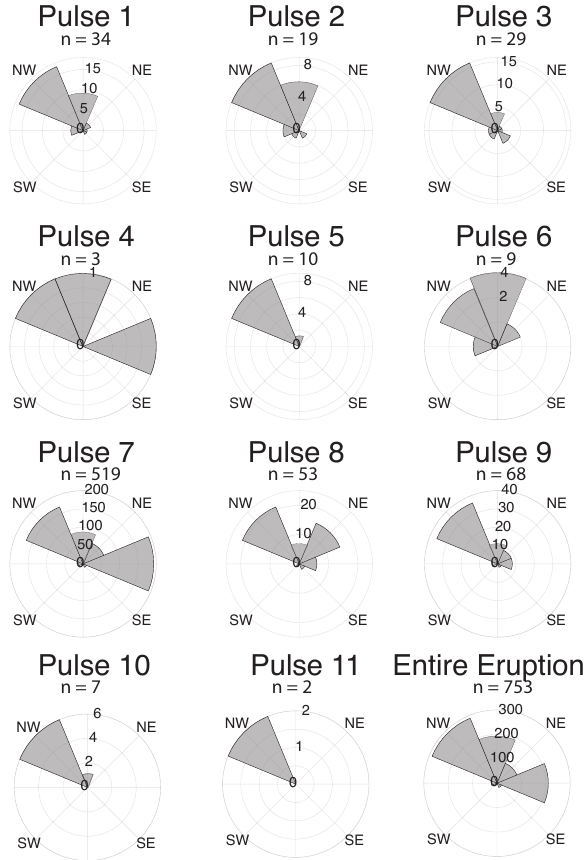
Figure 4: Rose diagrams showing the spatial location of light- ning from each of the eruptive pulses examined, binned into eight compass directions (N, NE, E, SE, S, SW, W, NW) with the location of the vent as the center; n = number of lightning strokes detected by the GLD360